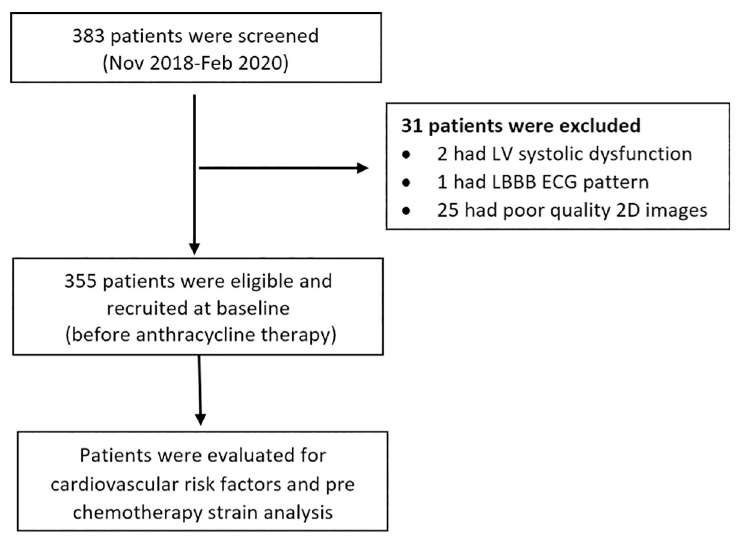
Fig 2. Patients’ flow chart.